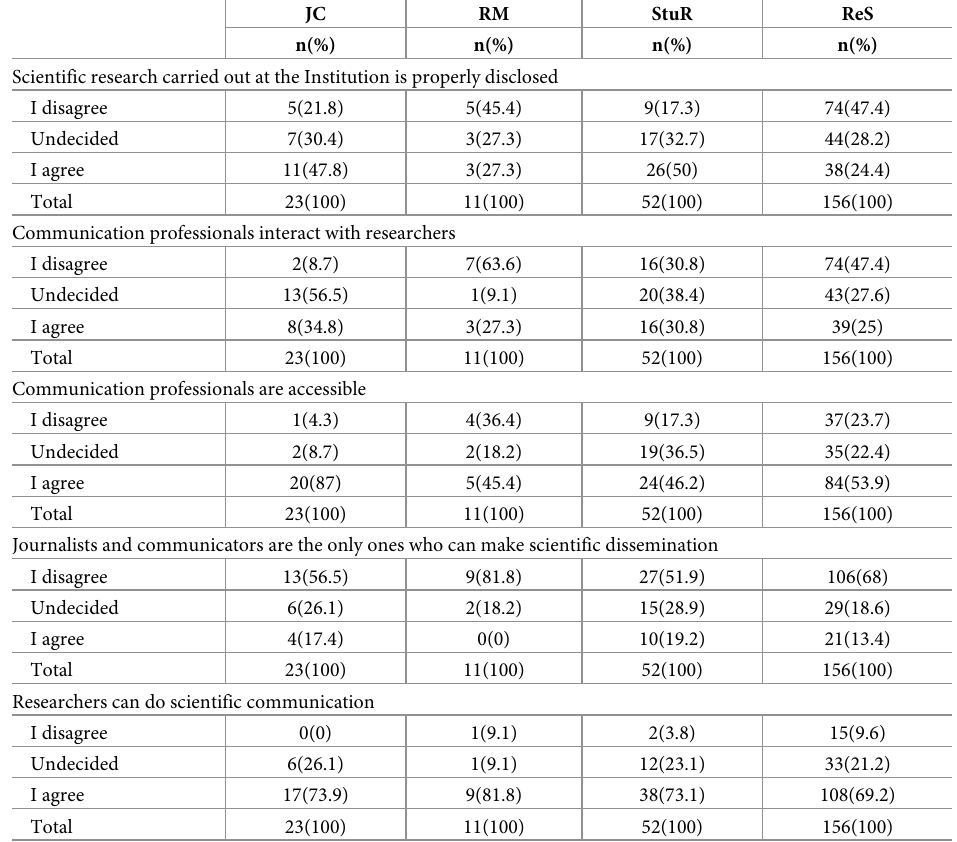
Table 4. Perceptions and relationship between communicators and